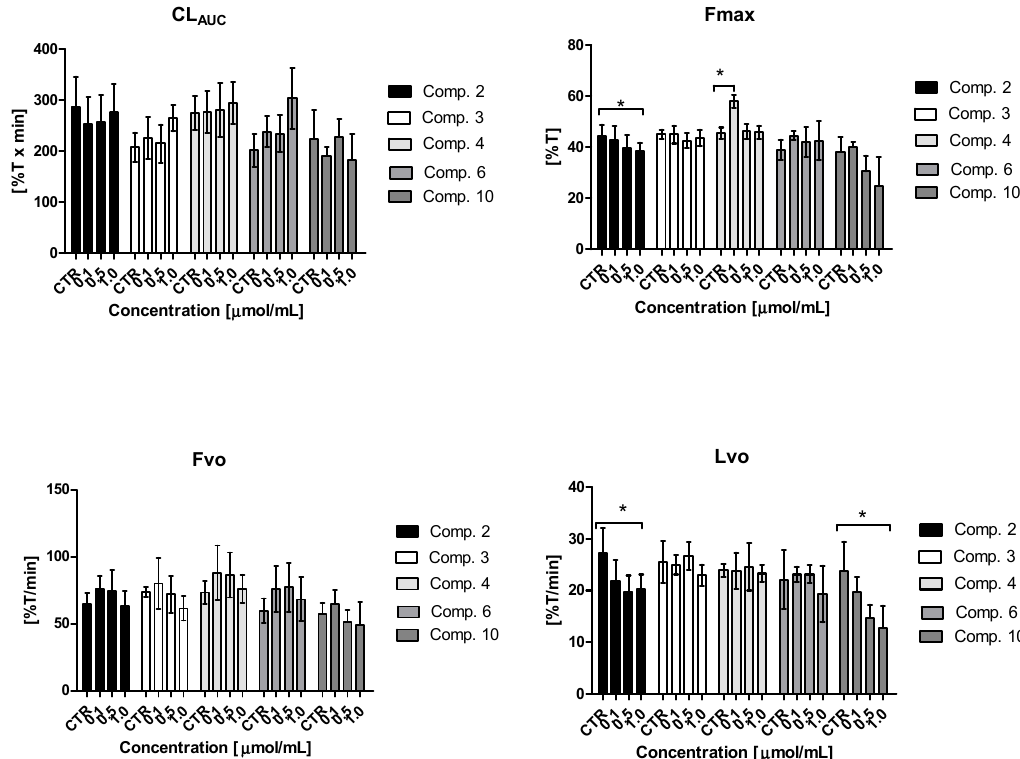
Figure 5. E ff ects of sulfonamides 2 , 3 , 4 , 6 , and 10 on the overall potential of clot formation and fibrinolysis (CL AUC ), and selected parameters of clot formation and fibrinolysis process: maximum clotting (Fmax); initial plasma clotting velocity (Fvo); initial clot fibrinolysis velocity (Lvo). The results are presented as mean ± standard deviation (SD), n = 5–6. * denotes significant di ff erence ( p < 0.05) between the sample with tested compound and respective controls. In our previous study metformin was found to not a ff ect the overall potential of clot formation and fibrinolysis (CL AUC ) over the entire concentration range. Metformin also did not influence the kinetic parameters of the process (Fmax, Fvo, Lvo constans) [22].